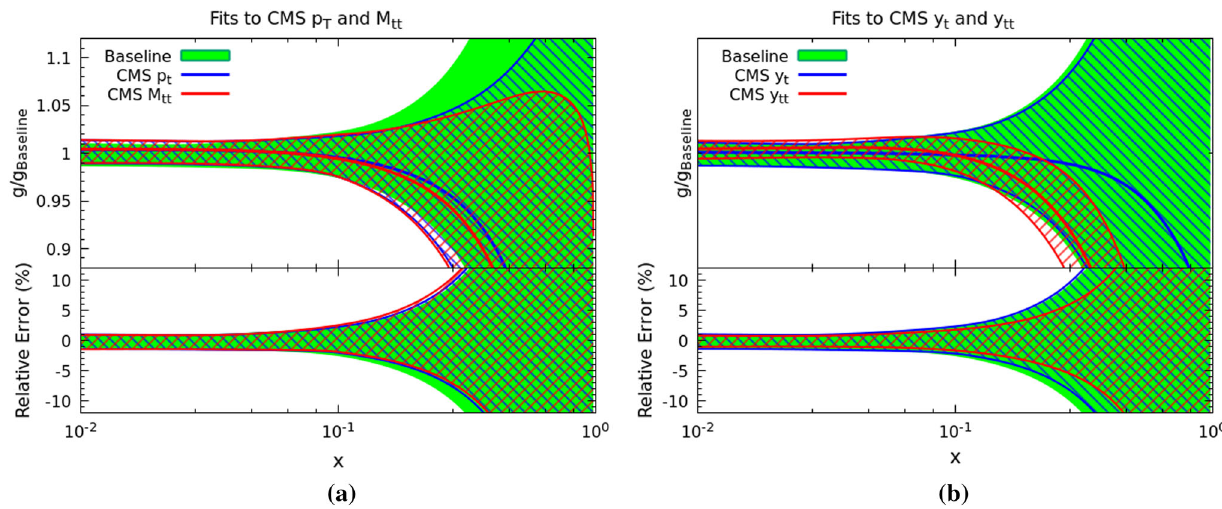
Fig. 10 Impact of the CMS 8 TeV lepton+jets data on the gluon PDF Table 7 χ 2 / N data breakdown for combined fits to ATLAS and CMS t ¯ t data. The fourth column corresponds to the relevant rapidity distribution from CMS that is used in the fit. The numbers in brackets indicate the χ 2 / N data when this distribution is fit individually Distribution p t ⊥ + M tt ATLAS lepton + jets (0.66) y tt ATLAS dilepton (0.66) CMS lepton + jets Total